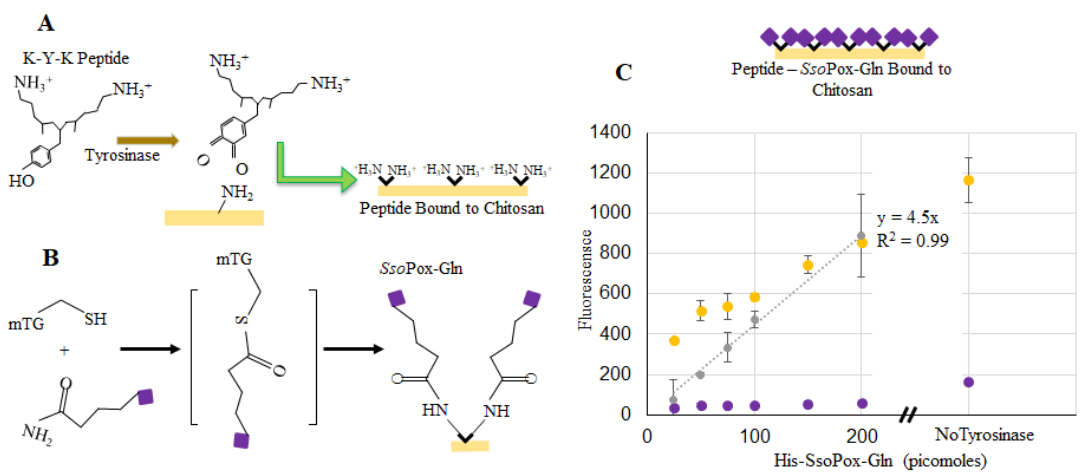
Figure 4: Sso Pox-Gln binding to chitosan. In ( A ), the binding of the K-Y-K peptide is illustrated using tyrosinase to form an o -quinone on the tyrosine residue which binds to the primary amine groups on chitosan. ( B ) shows the multi-step process whereby microbial transglutaminase (mTG) aids in binding the Sso Pox-Gln to the lysine groups of the peptide ( C ) indicates fluorescence readings at the completion of incubation (yellow) and again after washes (purple). Points represent the average of 3 points; error bars are the standard deviation. The gray line is a linear best-fit for the calculated bound enzyme.